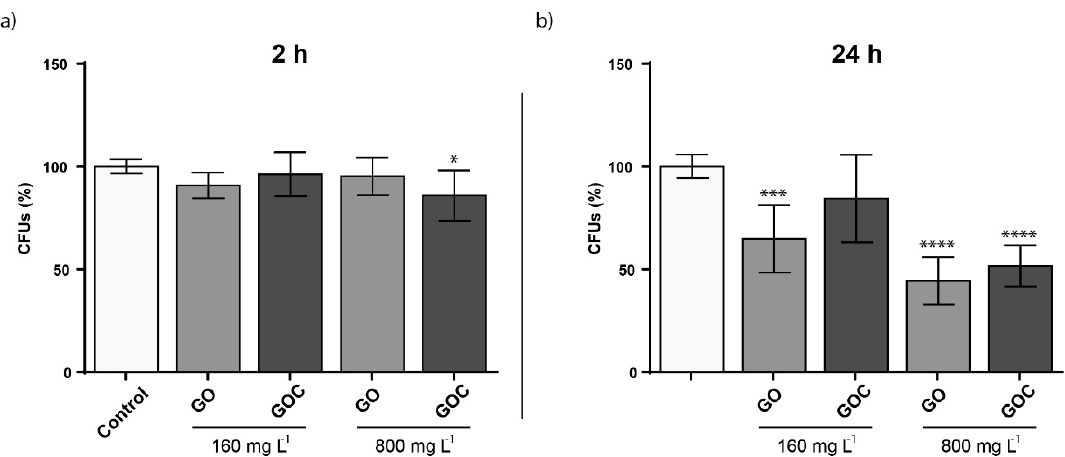
Figure 7. Colony forming units (CFUs) determination of S. cerevisiae cells exposed to 160 and 800 mg L − 1 of GO and GOC during 2 h ( a ) and 24 h ( b ). The reported values are the averages of three biological replicates per culture condition. Differences were established using a one-way ANOVA followed by Dunnett post hoc test to compare every mean with the control, and considered significant at p ≤ 0.05. * p ≤ 0.05, *** p ≤ 0.001, **** p ≤ 0.0001.